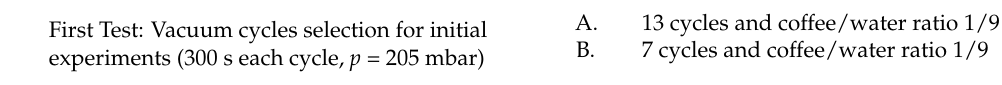
Table 1. Tests conditions for the determination of extraction parameters. First Test: Vacuum cycles selection for